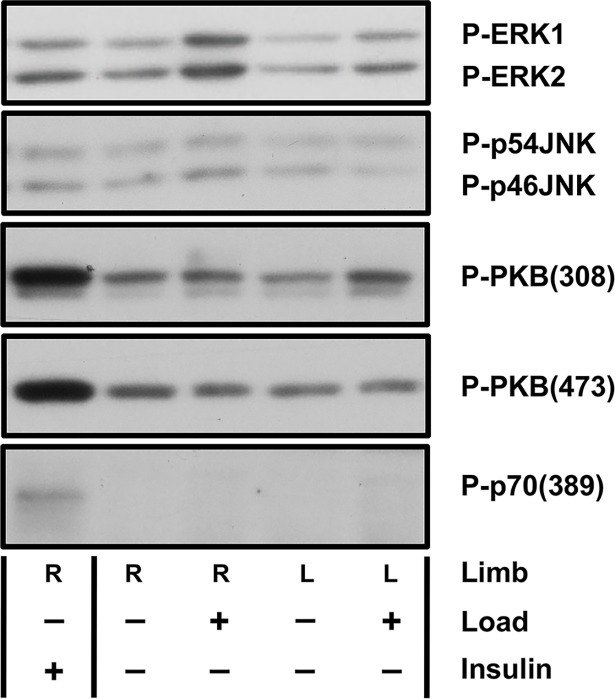
Representative Western blots for bone signaling at 15 minutes after loading.Insulin treatment served as positive control. Paired right and left limbs from Sham and Loaded rats were compared (n = 3/group). Phosphorylation of ERK and JNK were significantly increased in the loaded right ulnae at 15 minutes after loading compared to sham and contralateral limbs. The upper band was quantified for P-p54JNK.